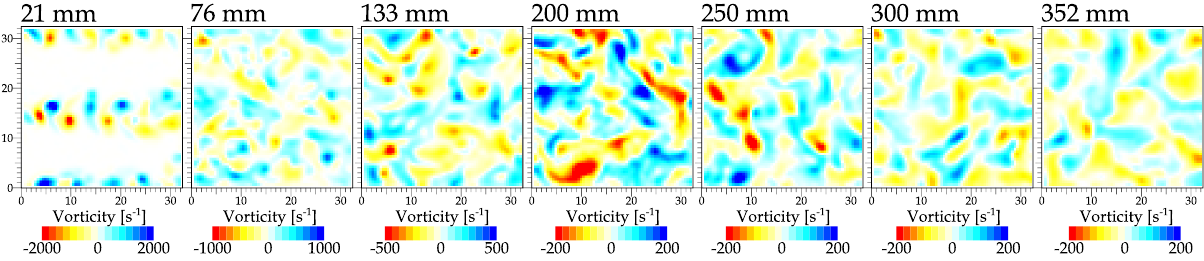
Fig. 2. Examples of spatial distribution of instantaneous vorticity ω in 7 studied areas (see figure 1). Stream-wise velocity (from left to right) is 3 . 0m / s corresponding to Reynolds number Re = 3 . 1 · 10 3 . Note the di ff erent color-scale of first three images.